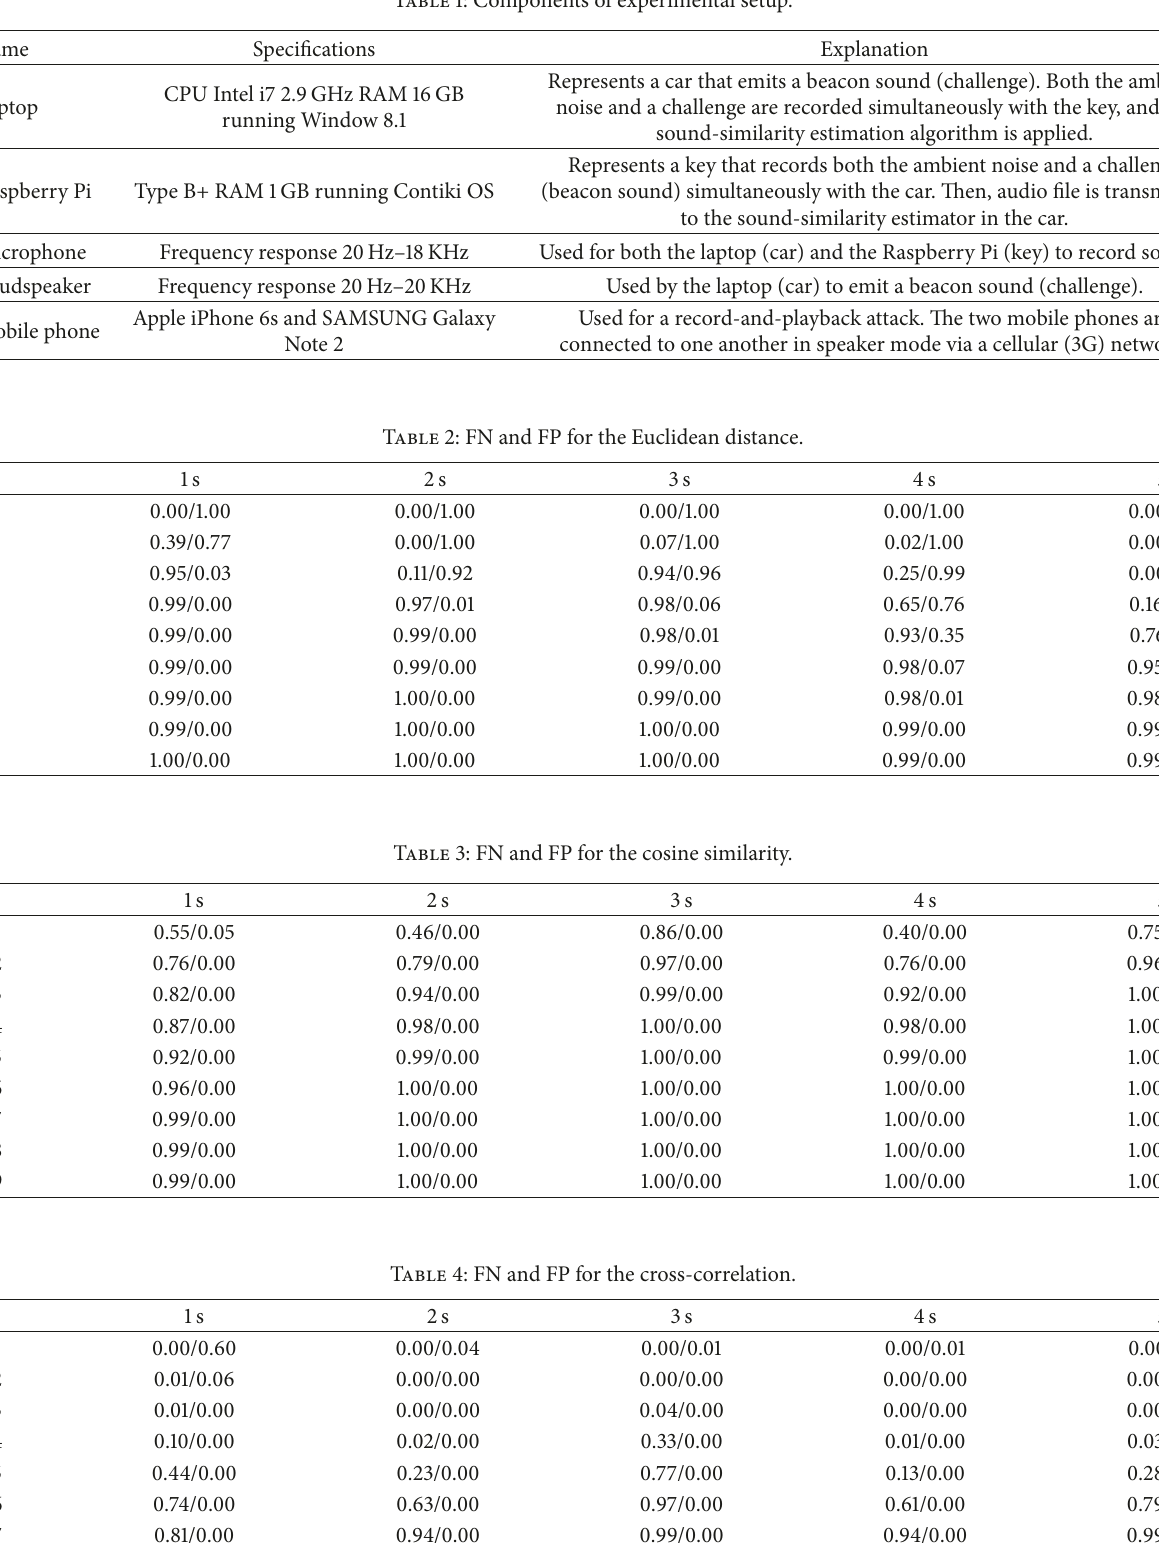
Table 1: Components of experimental setup.